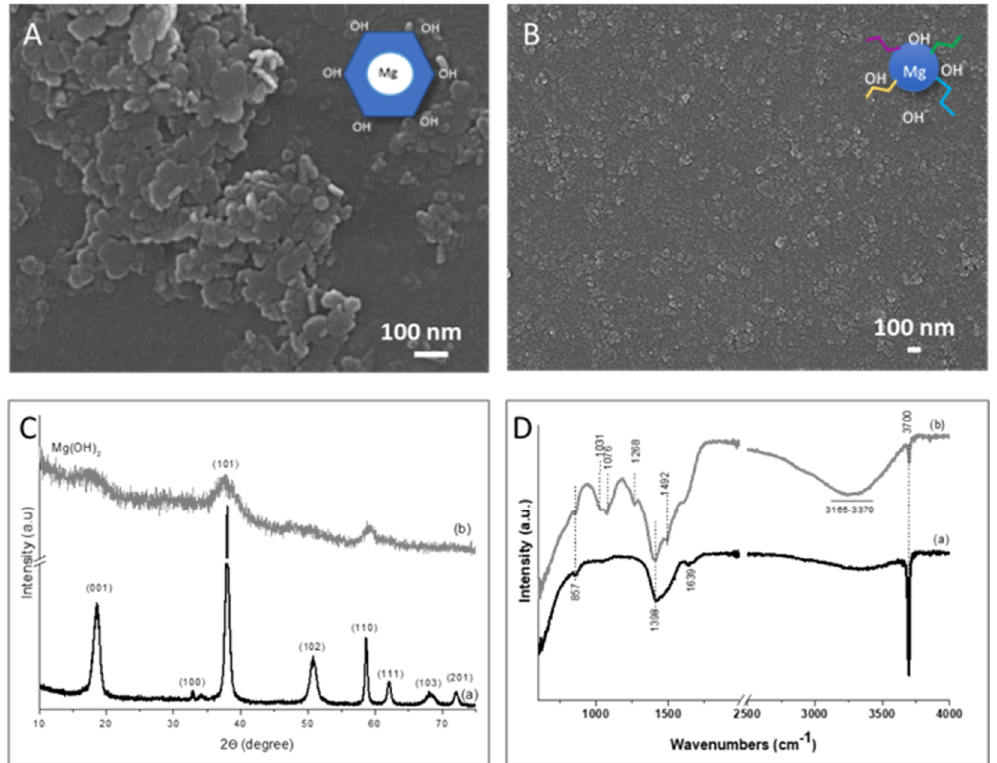
Figure 1. Mg(OH) 2 NPs synthesized using water or a RH extract. ( A ) and ( B )—SEM image of Mg(OH) 2 NPs ( A ) and Mg(OH) 2 RH NPs ( B ); ( C )—XRD diffractograms of Mg(OH) 2 NPs (a) and Mg(OH) 2 RH NPs (b); and ( D )—ATR–FTIR spectrum of Mg(OH) 2 NPs (a) and Mg(OH) 2 RH NPs (b).